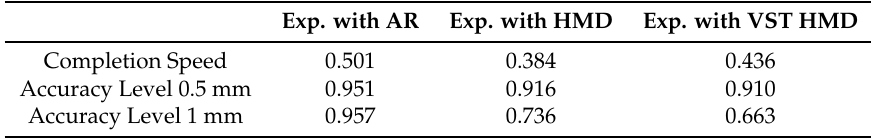
Table 3. p -values of the Kruskal–Wallis test.